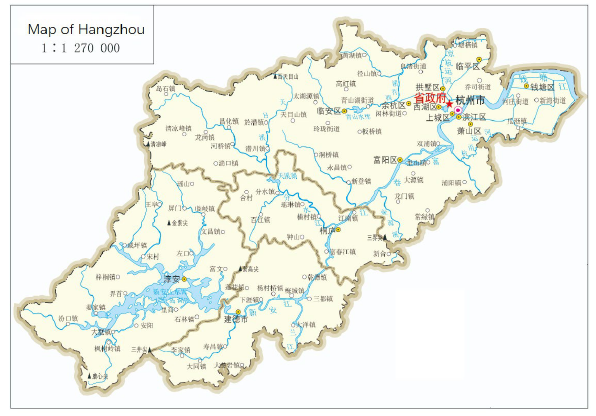
Figure 3. Map of